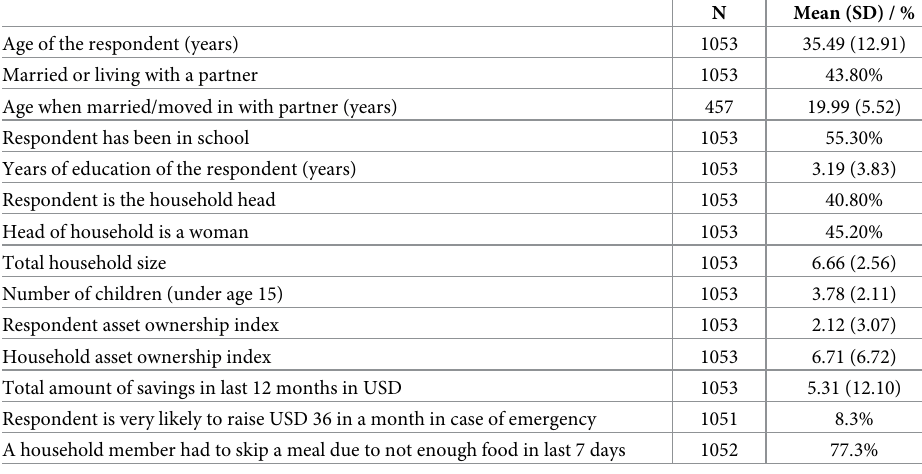
Table 1. Respondent characteristics at baseline.